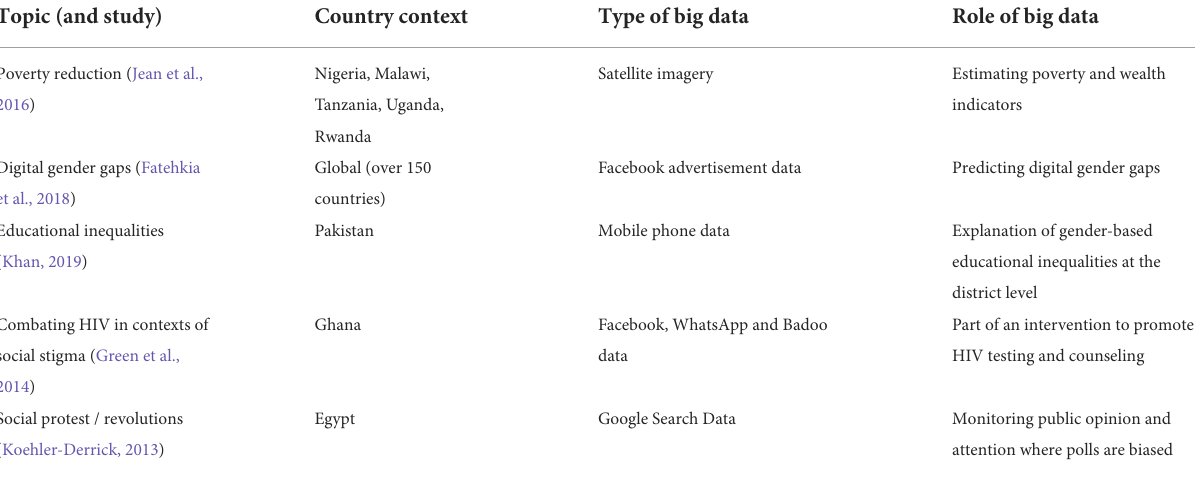
TABLE 2 Five examples of Big Data used in sociologically relevant development